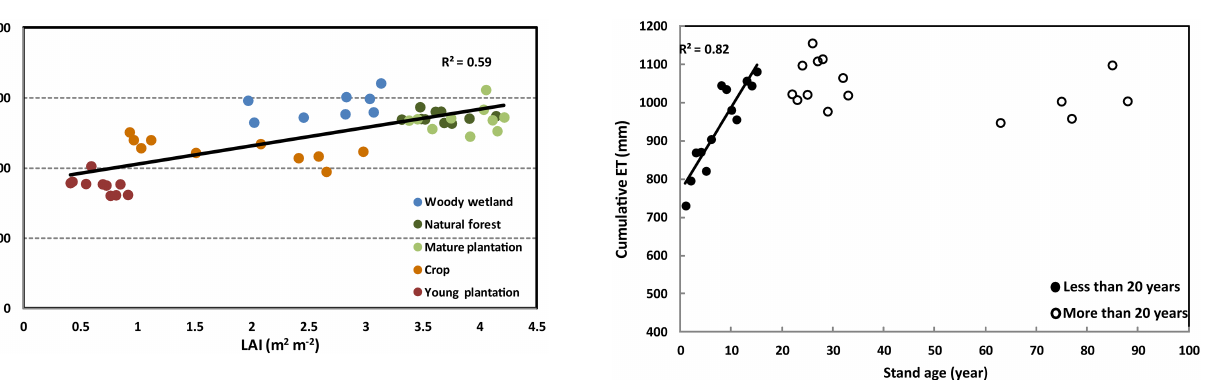
Figure 16. Modeled cumulative ET from DOY 50 to DOY 330 as a function of LAI. Figure 17. Modeled cumulative ET at DOY 330 as a function of